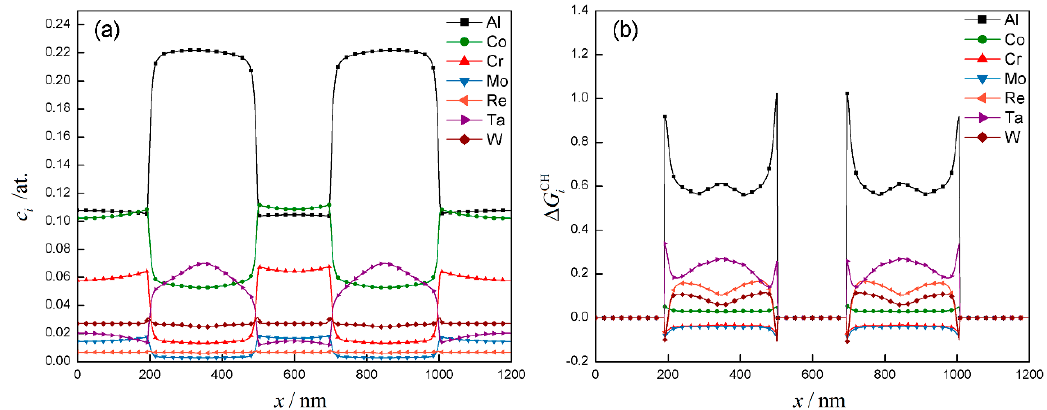
Figure 12. The elements distribution ( a ) and chemical driving force distribution ( b ) of DD6 superalloy after 1120 ◦ C / 2 h.